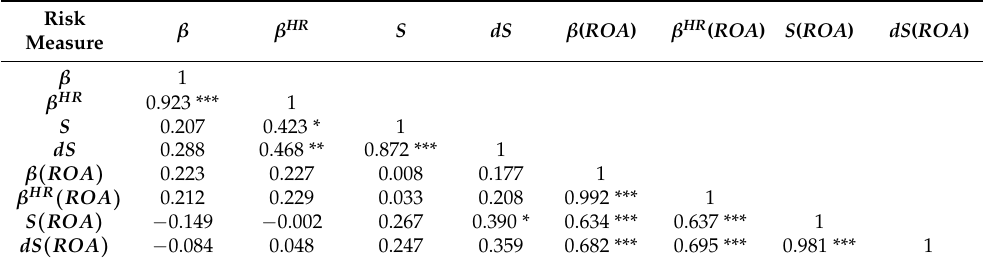
Table 7. Correlation coefficient between risk measures for energy